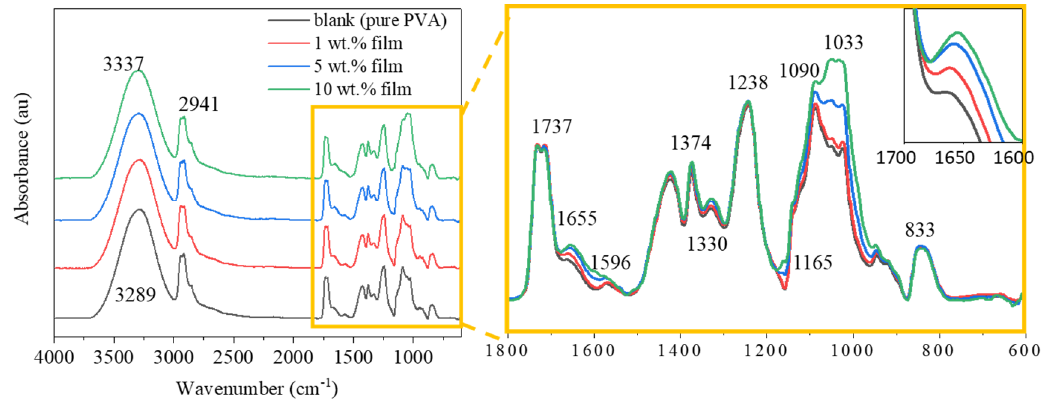
Figure 5. Fourier Transform Infrared (FTIR) spectra of pure PVA and hemp/PVA composite films.